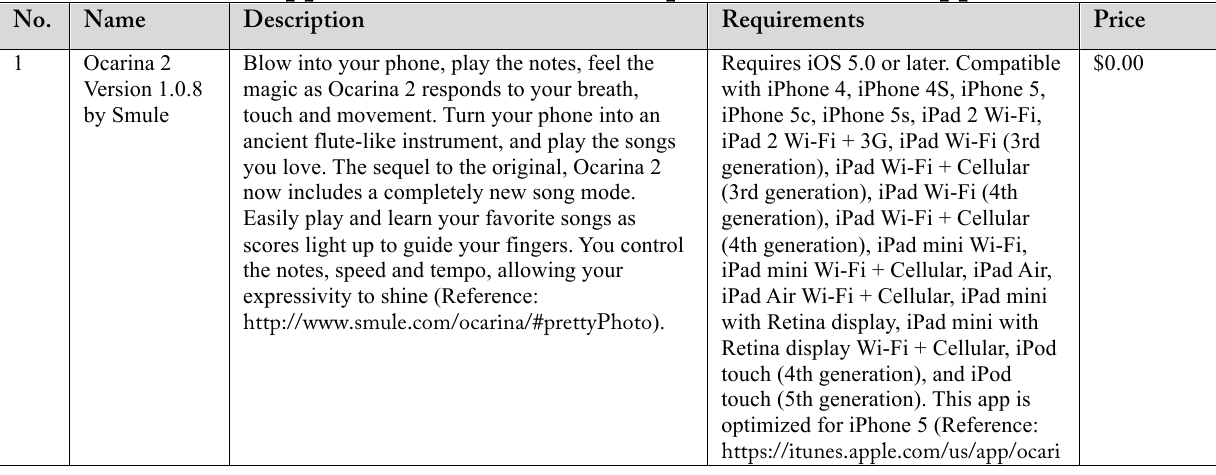
Table 3.1: Mobile applications for music composition (iTunes App Store, 2013) N